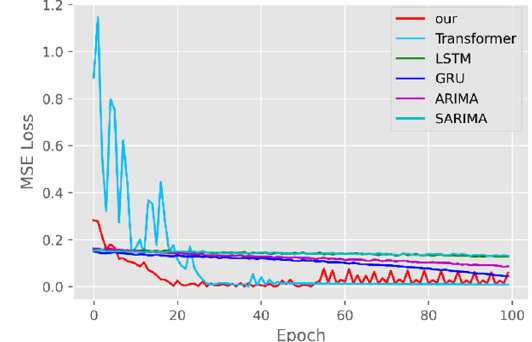
Figure 8. Comparison of training loss for NY cases and deaths.